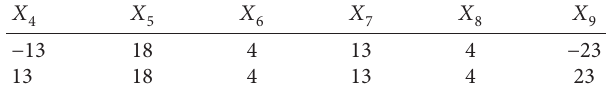
Table 7: Model-free checks with edge plan in Table 6.